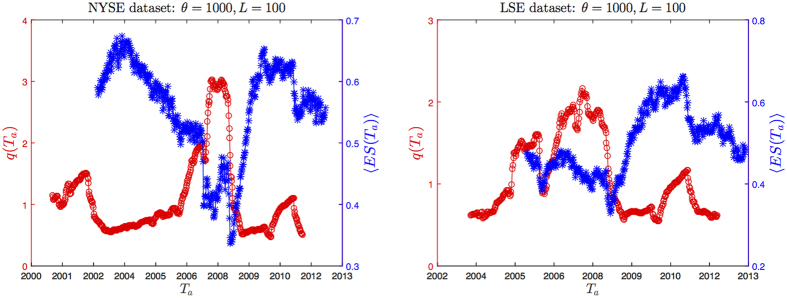
〈ES〉(Ta) and q(Ta) signals represented for θ = 1000 and L = 100, for both NYSE (left graph) and LSE (right graph) datasets.It is evident the anticorrelation between the two signals. The financial crisis triggers a major drop in the structural persistence and a corresponding peak in q(Ta).